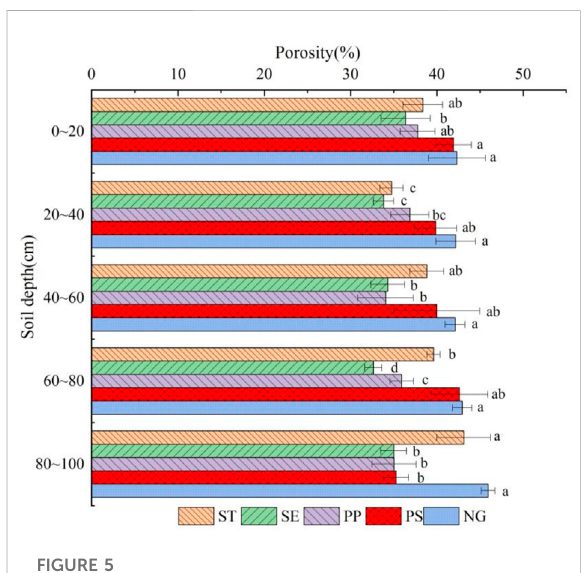
FIGURE 5 Porosity of different soil layers under each vegetation